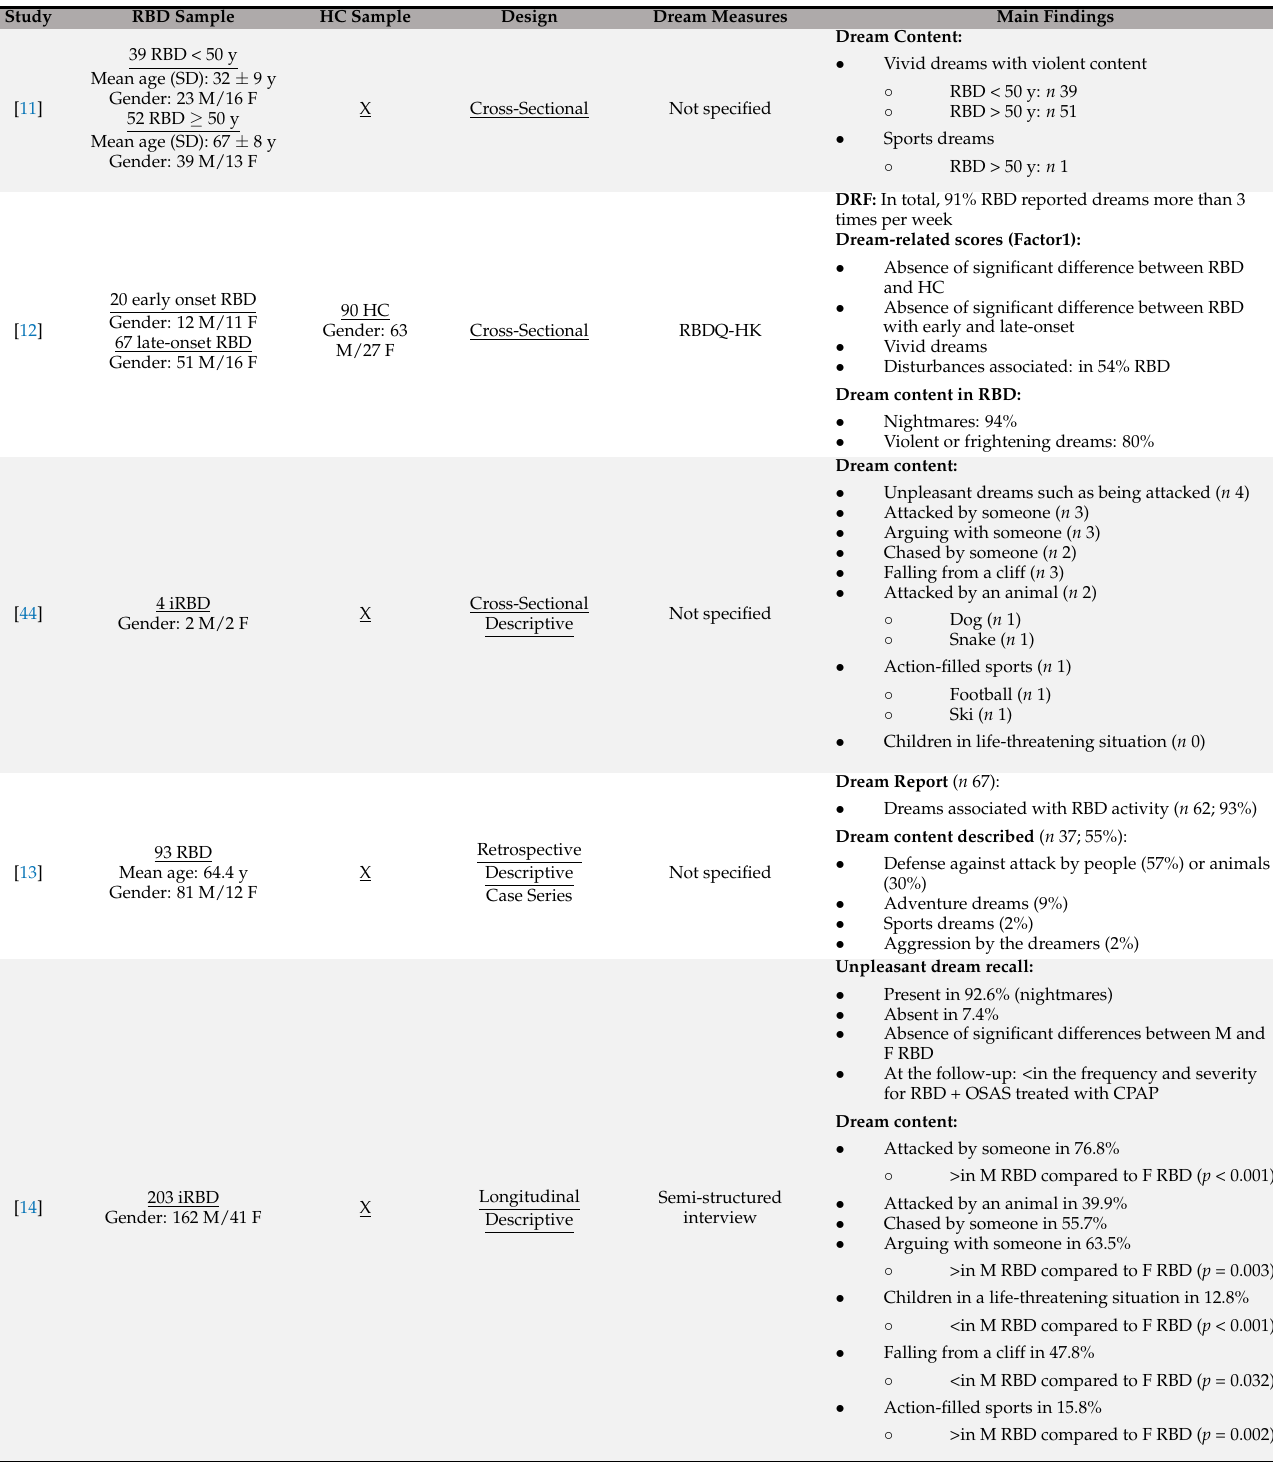
Table 1. Sample, design, tools, and findings in studies investigating dreaming in RBD and RBD vs. HC. Legend: X = absence of HC